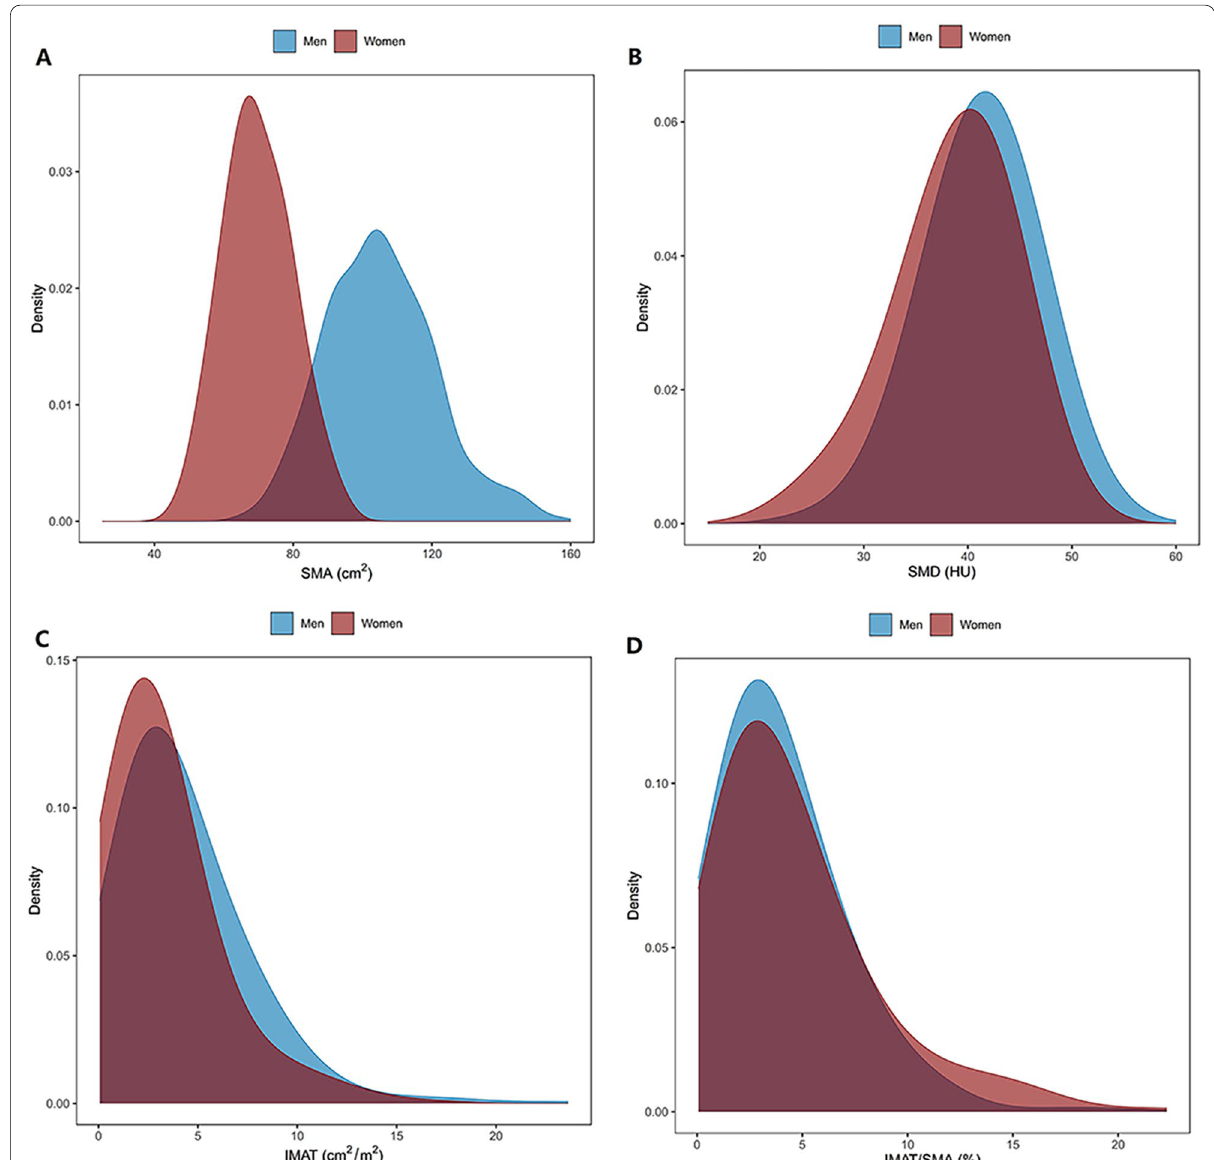
Fig. 2 Density distribution of SMA ( A ), SMD ( B ), IMAT ( C ), and IMAT/SMA ( D